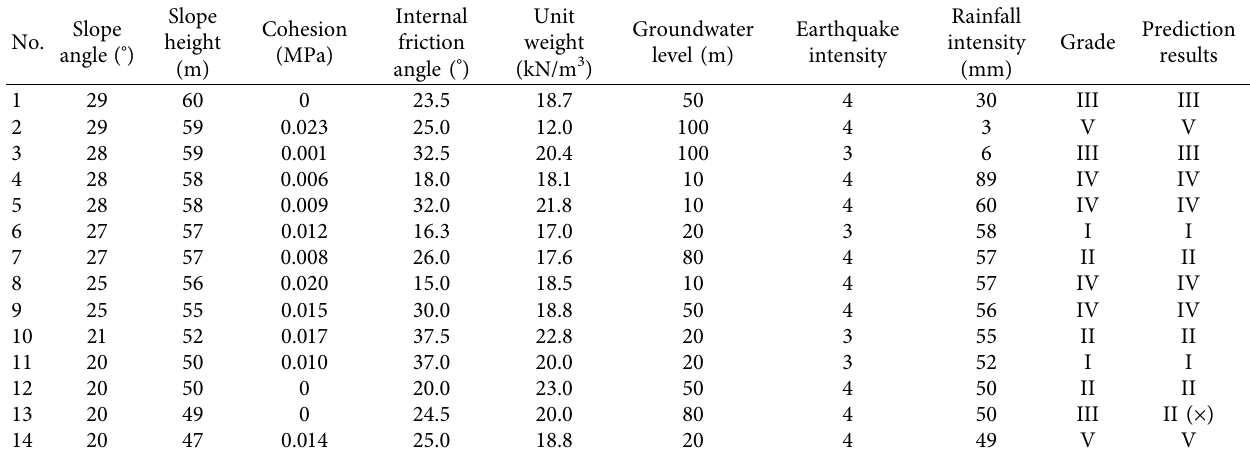
Table 4: Test samples of the slope